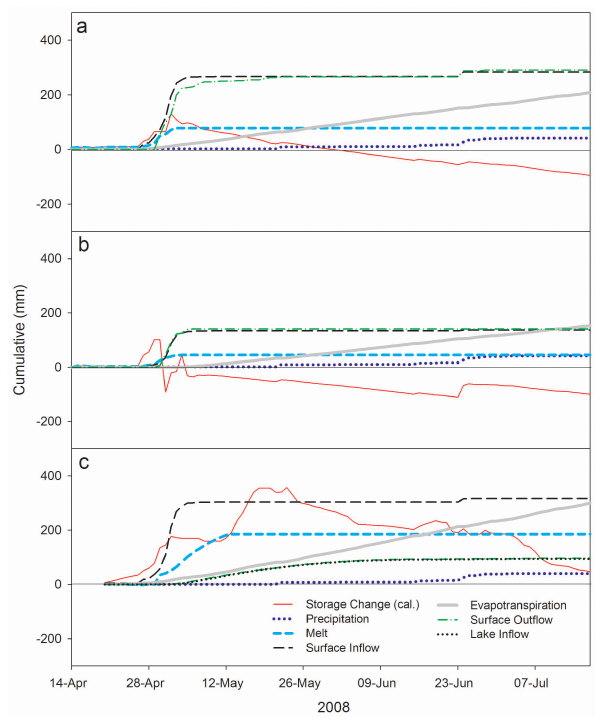
Fig. 3. Cumulative water budget for the (a) peatland, (b) valley, and (c) wetland sites (mm per unit area) for 14 April to 17 July 2008. For display purposes, surface inflow and outflow values are 1/10th of actual for the valley site (i.e. ∼ 137mm of cumulative in- flow shown in graph is representing the actual ∼ 1370mm; total sur- face outflow was 34mm higher than surface inflow). Surface out- flow and lake inflow are 1/100th of actual for the wetland site (total surface flow was 196mm higher than Lake 690